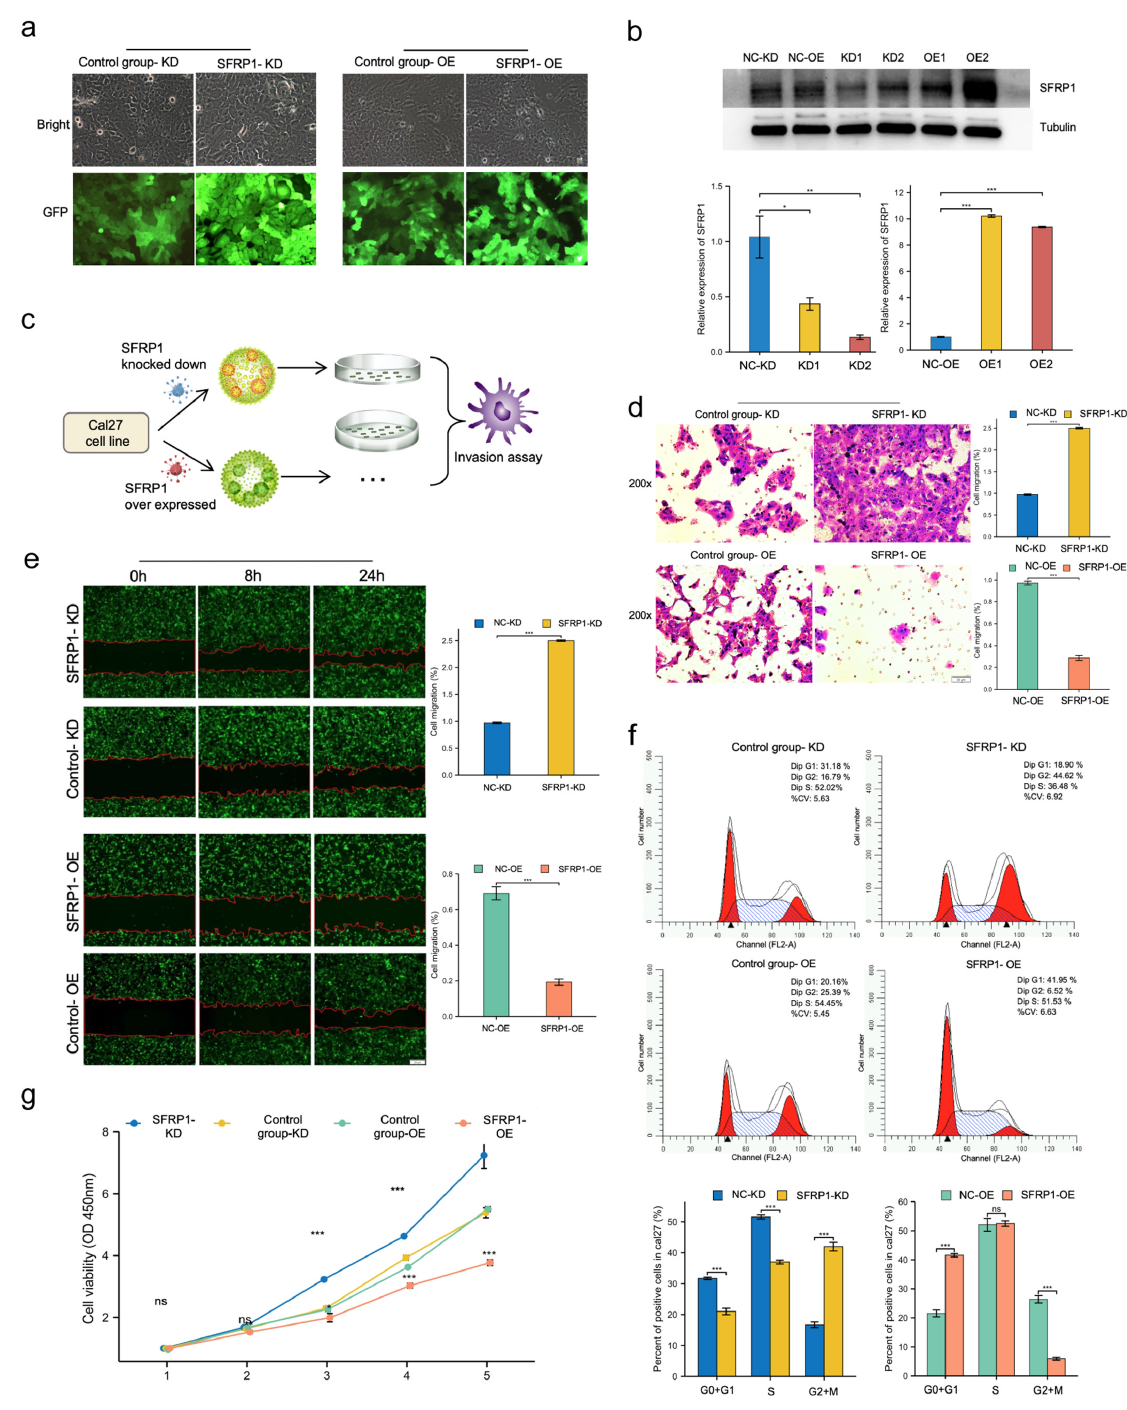
Figure 9. SFRP1 represses invasion, migration and proliferation of Cal27 cells in vitro. ( a ) SFRP1 was knocked down and overexpressed in Cal27 cells by lentivirus transfection. ( b ) Upper, Western blotting was used to verify SFRP1 protein level; lower, RT-PCR was utilized to detect SFRP1 expression in Cal27 cells. ( c ) Flow chart of transwell assay. ( d ) Overexpression of SFRP1 inhibited the invasion of Cal27 cells through the chamber. ( e ) Wound-healing assay demonstrated that SFRP1 overexpression inhibited cell migration. ( f ) Flow cytometry analyses of cell cycles of SFRP1 overexpressed and knocked down cells and their respective negative control cells. ( g ) CCK8 assays were performed to detect Cal27 proliferation based on the absorbance at various points of the day at 450 nm. * p < 0.05, ** p < 0.01, *** p <